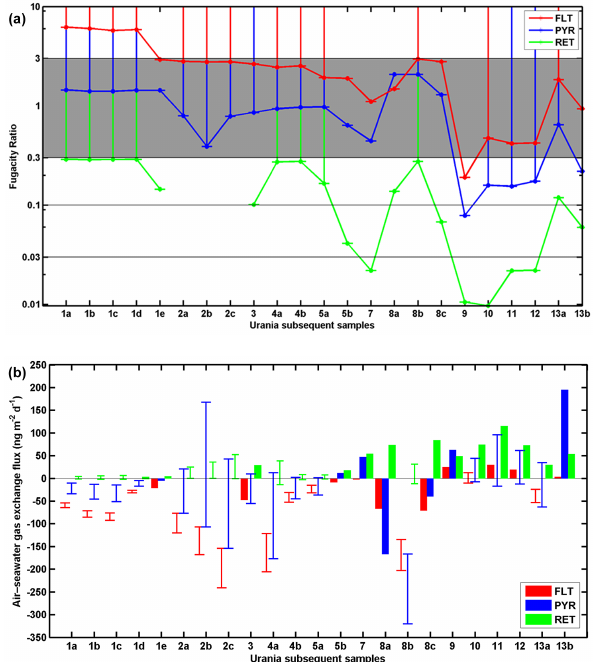
Figure 1. Air–sea exchange, (a) fugacity ratios FR = f a /f w (volatilisation >3, deposition <0.3, grey area insignificant deviation from phase equilibrium) and (b) flux F aw (ngm − 2 d − 2 ; volatilisa- tion >0, deposition <0) of FLT, PYR and RET during the cruise of RV Urania . Error bars indicate sea water concentration C w <LOQ. The x axis depicts the correspondence of sequential pairs of air sam- ples (1–13) and water samples (a–e)